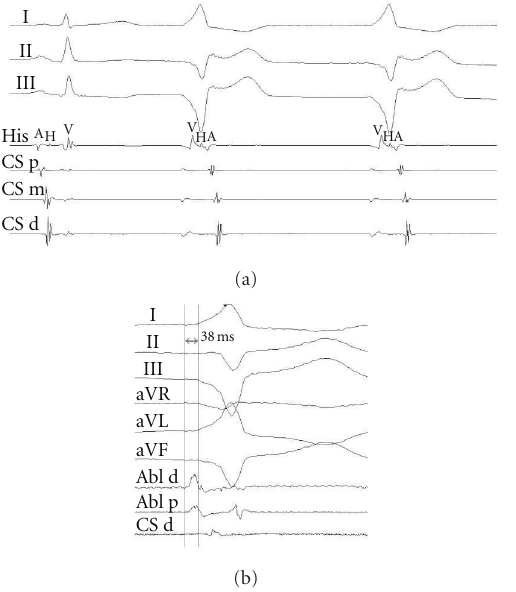
Figure 3: (a) The ventricular discharges with retrograde conduc- tion over the AV node (second and third beats). (b) Early presystolic activity at the ablation site in the middle cardiac vein. Abl d, electrogram from the distal pair of the ablation catheter; Abl p, from the proximal